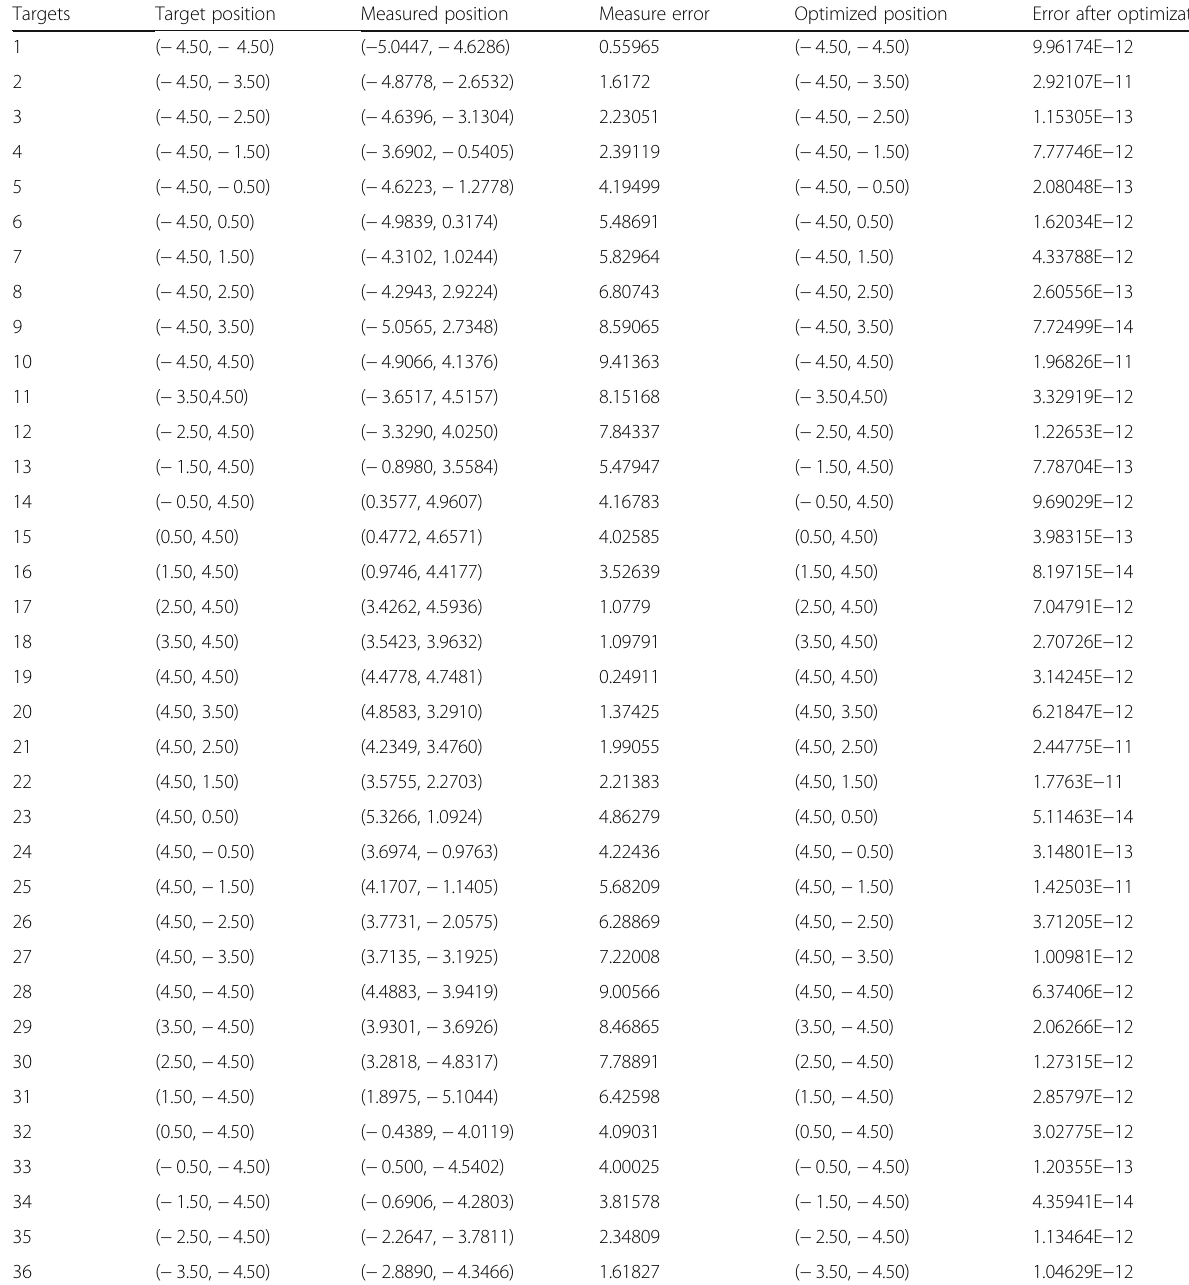
Table 4 Performance of 2D indoor localization using ELPSO